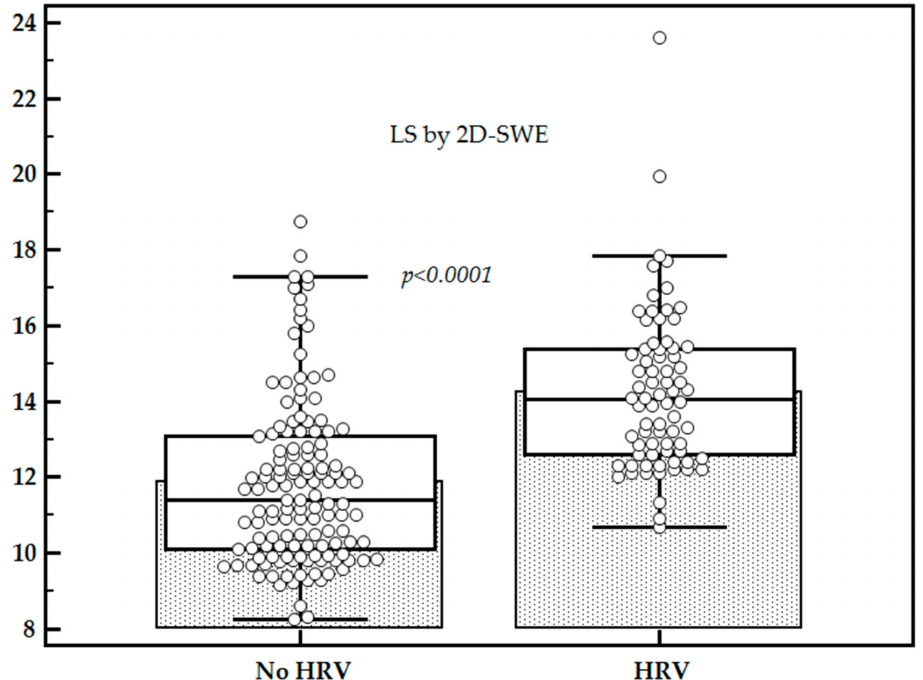
Figure 2. Comparison between liver stiffness (LS) values in subjects with high-risk varices (HRV) vs. subjects without HRV.